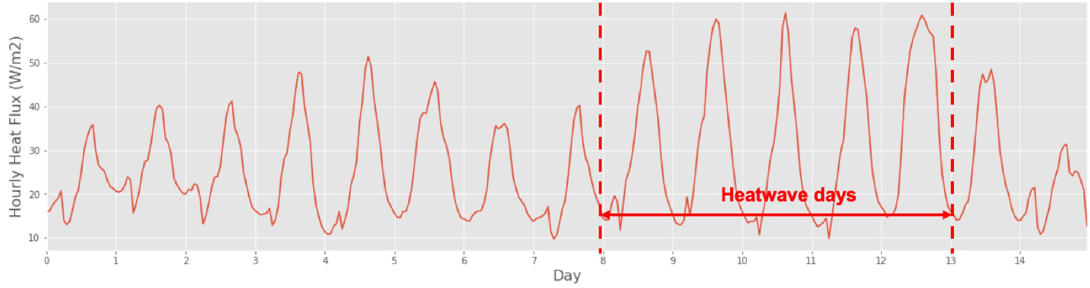
Figure 11. Grid‐average hourly heat flux from buildings to the atmosphere.